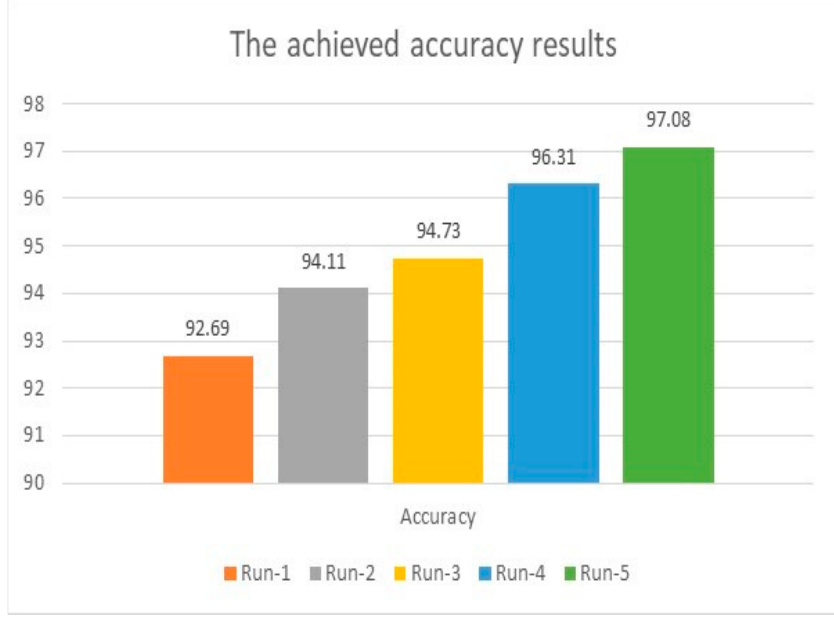
Figure 7. Accuracy evaluation using LSTMs model.